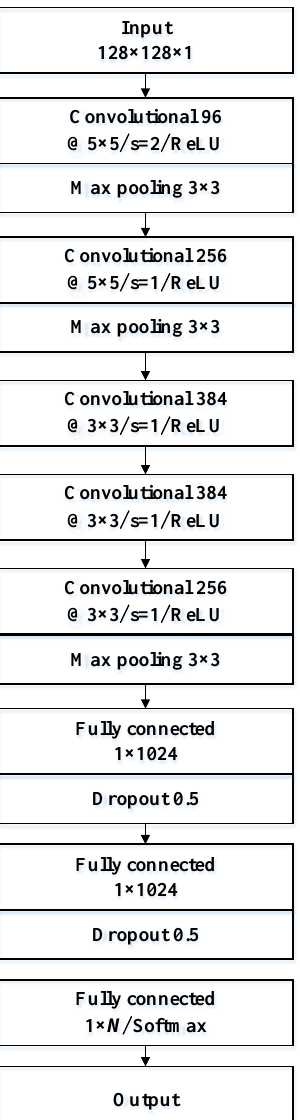
Figure 7. Structure of the classification